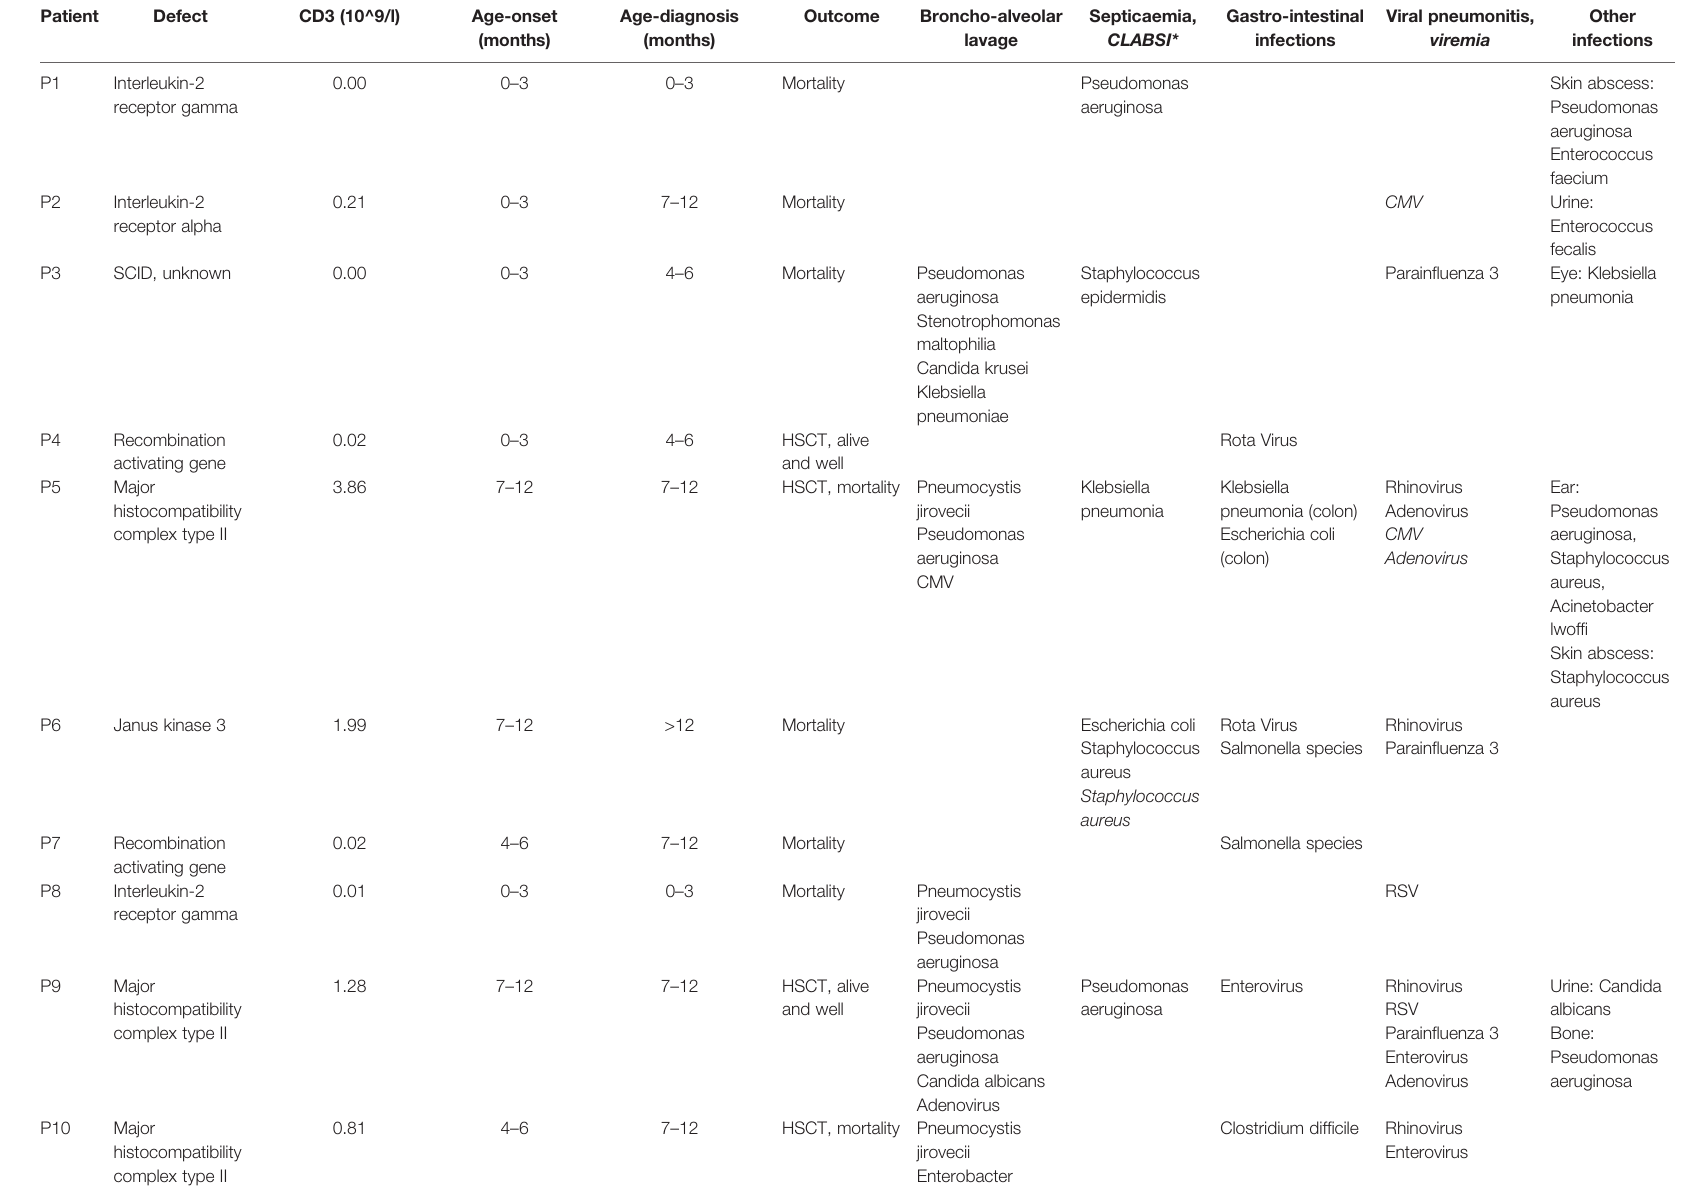
TABLE 2 | Clinical features of 36 children with SCID